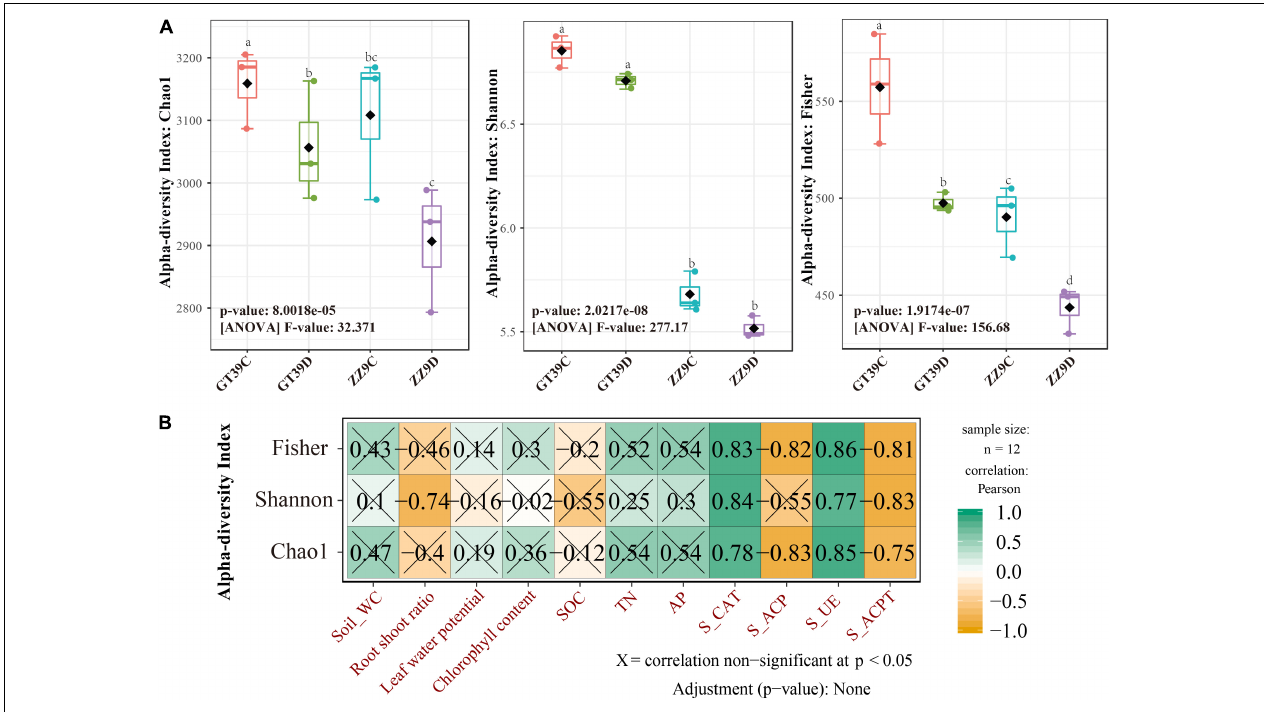
FIGURE 1 | Analysis of differences in microbial diversity based on water treatment and variety differences. (A) Measured values of rhizobacteria alpha diversity in Chao 1 abundance, Shannon diversity, and Fisher among different water treatments and cultivars. (B) Analysis of the relationship between bacterial alpha diversity and environmental factors using Pearson